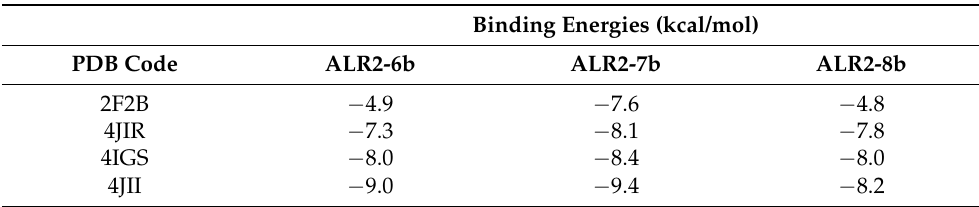
Table 3. Binding energies obtained from the molecular docking of compounds 6b , 7b , and 8b into different conformations of human